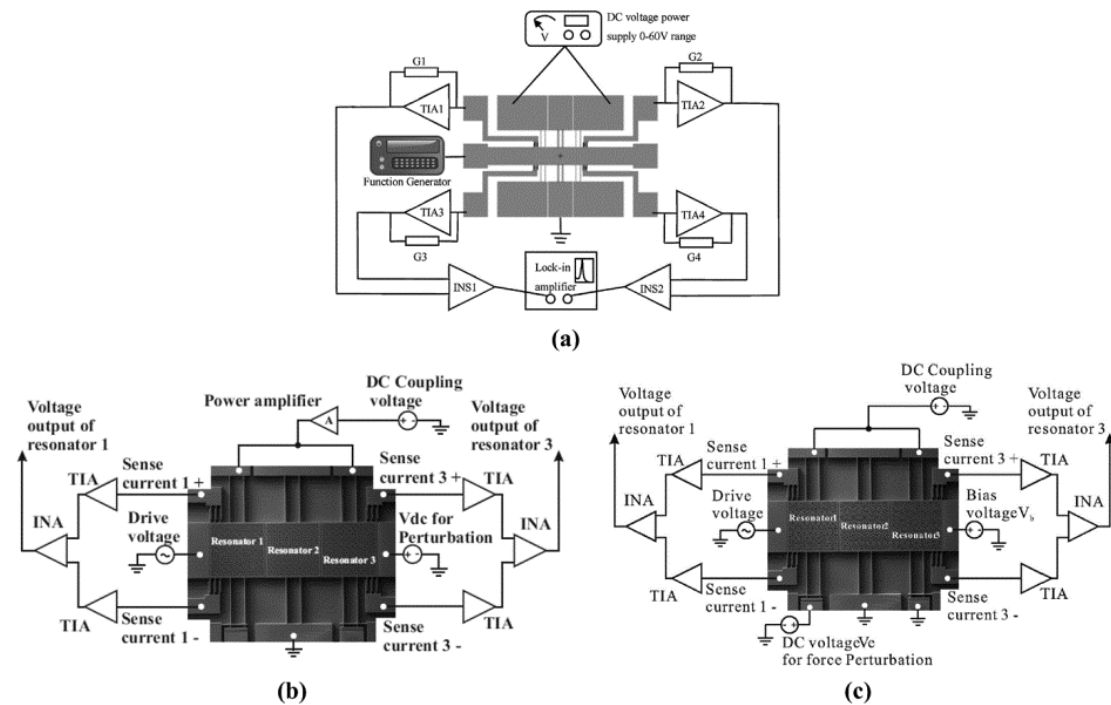
Figure 13. The electrically coupled three resonators ( a ) mass sensor. Reproduced with permission from [81]. © 2018 Elsevier B.V. ( b ) stiffness sensor. Reproduced with permission from [84]. Copyright © 2015, IEEE. ( c ) force sensor. Reproduced with permission from [87]. © 2015 Elsevier B.V. Table 4. Comparisons of EL-SCRB sensors for stiffness and force detections.